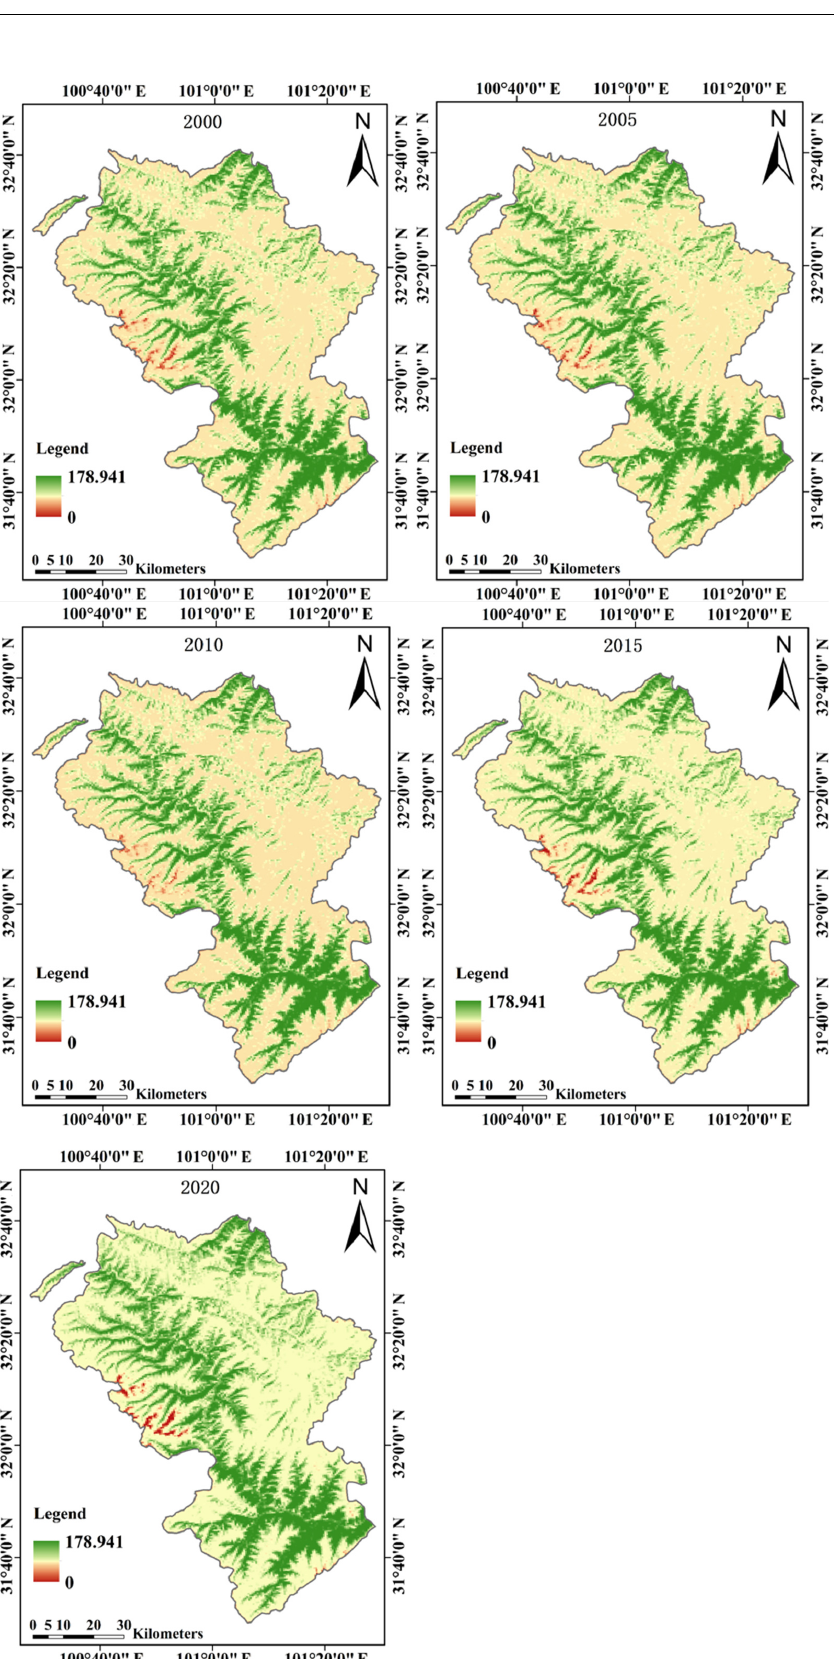
Figure 7. The change of biological richness index in Rangtang County. The average biological richness index in Rangtang County was 57.03 in 2000, 57.34 in 2005, 58.22 in 2010, 60.31 in 2015, and 60.97 in 2020. The index is higher in green areas, middle in yellow, and lower in red. Since 2000, as time went by, most of the middle area changed from red to green, and the biological abundance of the whole county showed an upward trend. In general, the index of Rangtang county increased by 3, and the ecological environment quality was improved. 4.1.3. Vegetation Cover According to Formula 4, the vegetation cover in Rangtang County was calculated as shown in Figures 8 and 9.